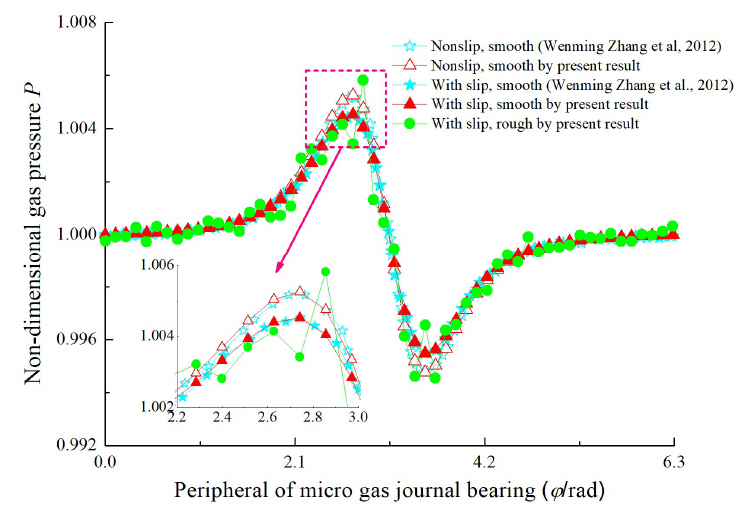
Figure 4. Comparison of dimensionless gas film pressure with Zhang et al. [20].